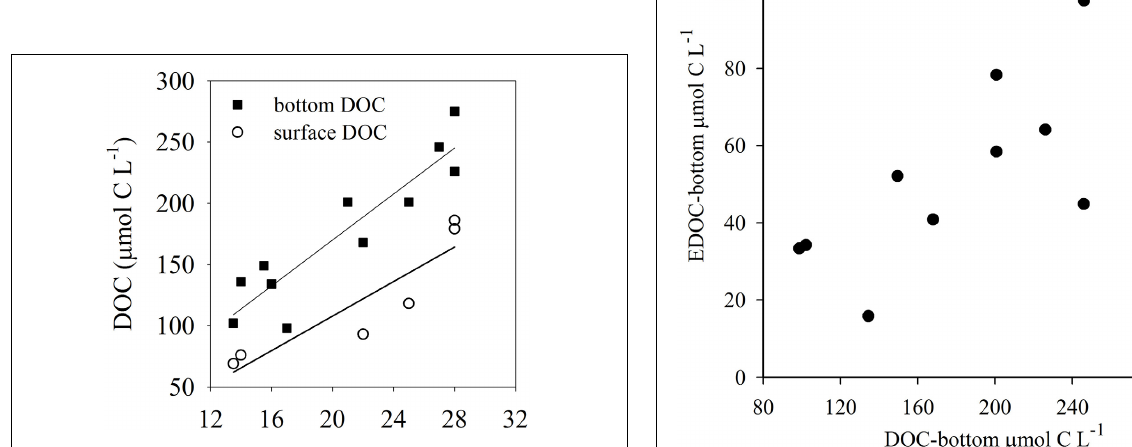
FIGURE 3 | Relationship between ambient DOC and EDOC collected in bottom waters where core collection took place. Although there is a tendency toward higher values of EDOC with high DOC concentrations, the relationship is not significant ( R 2 = 0 . 22, p > 0 .